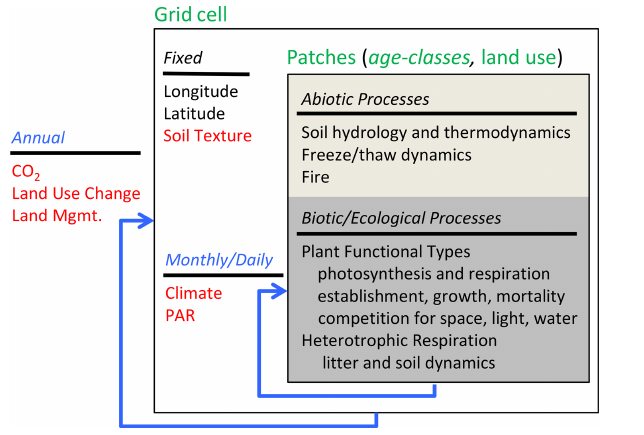
Figure 1. LPJ-wsl v2.0 model structure of inputs (red), time steps (blue), and the level at which state variables are tracked within grid cells and sub-grid-cell age classes (green), such as age classes or land uses. Simulation of abiotic, biotic, and ecological processes occurs at the scale of an age